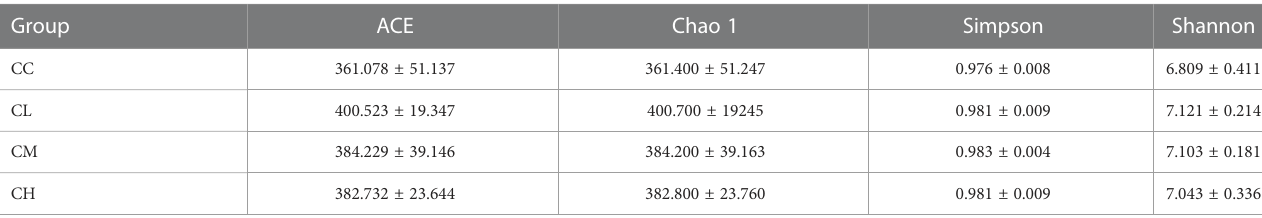
TABLE 1 Effect of GFPS on Alpha diversity index of intestinal content microbiota in mice. Group